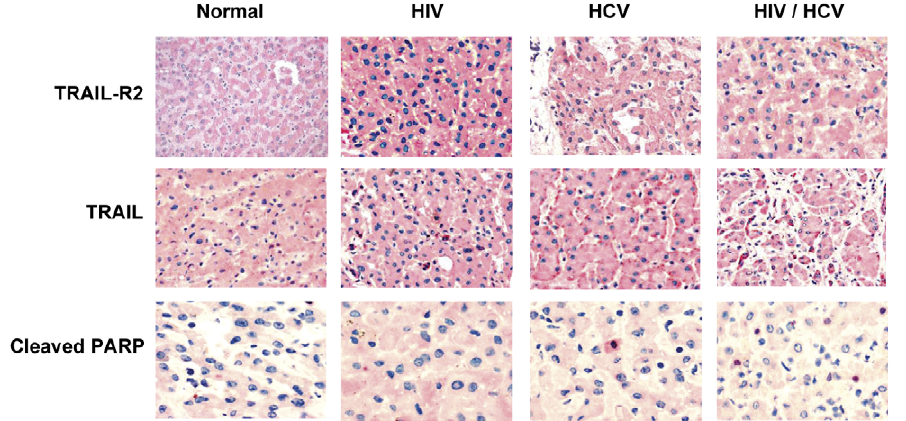
Figure 4. Invivo analysis of TRAIL, TRAIL-R2 and Apoptosis in Human Livers. Liver samples from 10 HIV infected, 10 HCV infected, 10 HIV/ HCV infected or 10 uninfected individuals were stained by Immunohistochemistry for TRAIL, TRAIL-R2 or cleaved PARP. The images were taken with an Olympus Microscope with the 20x objective (TRAIL, TRAIL-R2), and 40x objective (PARP). Representative samples are shown.